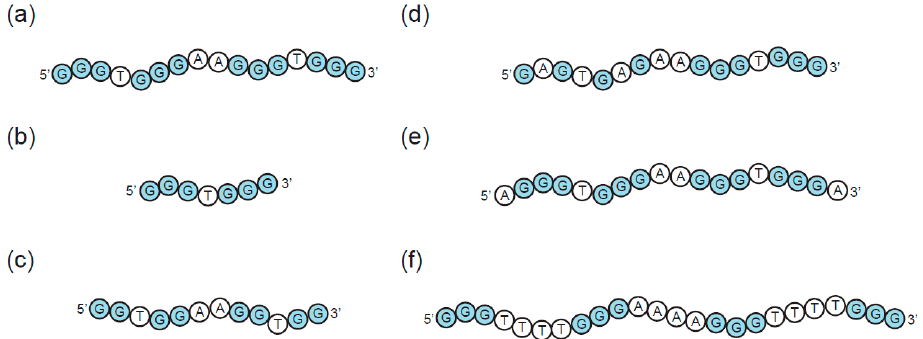
Figure 5. Sequence requirements of multimeric GQs. ( a ) Example of a canonical GQ. ( b ) Variant containing two rather than four G-runs. Such a sequence can form a multimeric GQ but not a monomeric one. ( c ) Variant containing G-runs of two rather than three nucleotides. In some cases, such sequences form multimeric rather than monomeric structures. ( d ) Variant containing mutations in